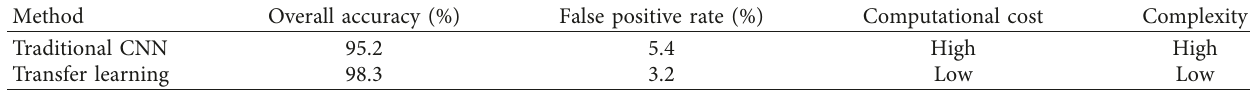
Table 5: Comparative analysis of performance of two models.